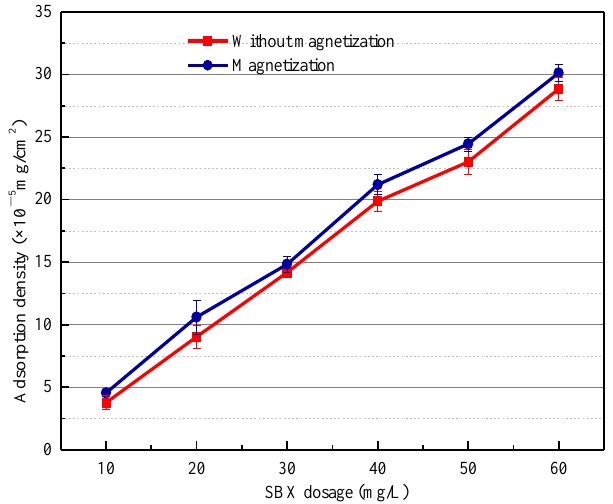
Figure 8. The relationship between butyl xanthate dosage and adsorption density.